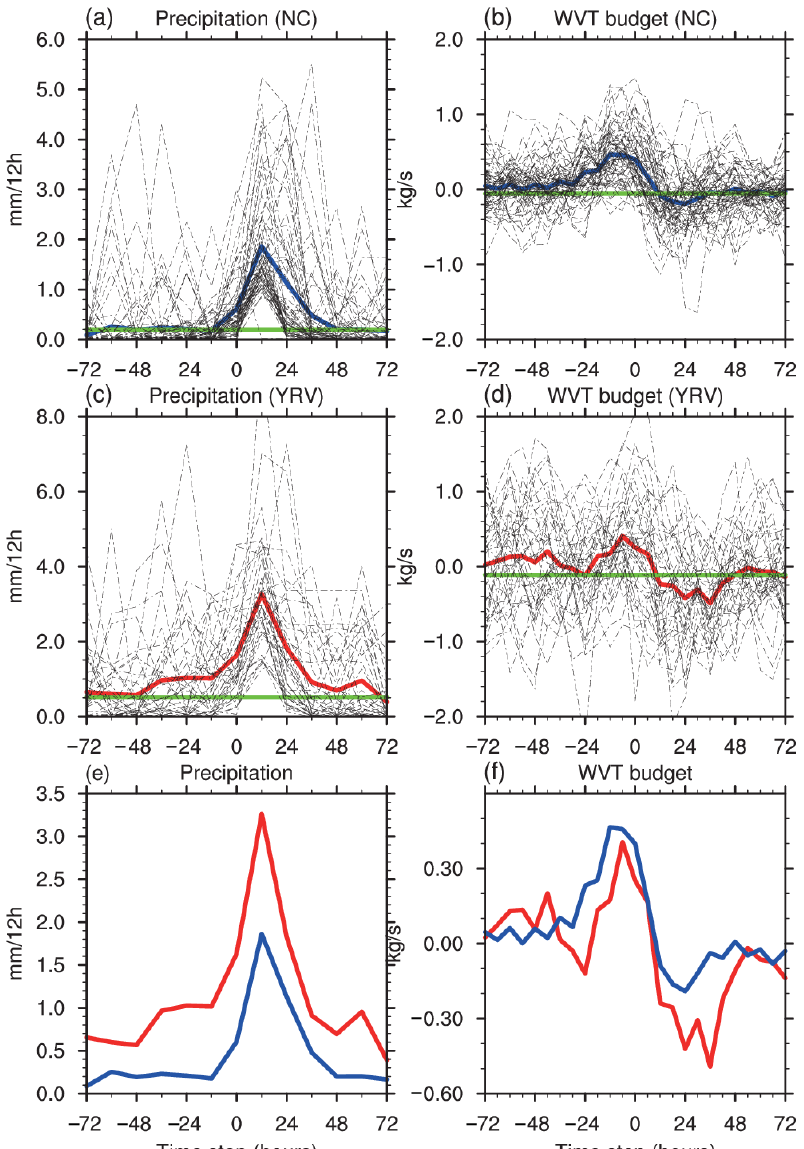
Figure 6. Evolution of ( a , c ) areal mean 12-h cumulative precipitation (mm) and ( b , d ) net water vapor flux (10 8 kg/s) over ( a , b ) NC and ( c , d ) the YRV region in the 72 h before and after the breakout of ISEs, where the black lines represent the individual cases, the thick blue and red lines represent the corresponding averages and the horizontal green lines represent the corresponding winter climatology. Evolution of ( e ) areal mean 12-h cumulative precipitation (mm) and ( f ) net water vapor flux (10 8 kg/s) over NC (in blue) and the YRV region (in red) in the 72 h before and after the breakout of ISEs. Time step 0 represents the beginning time of the ISEs.